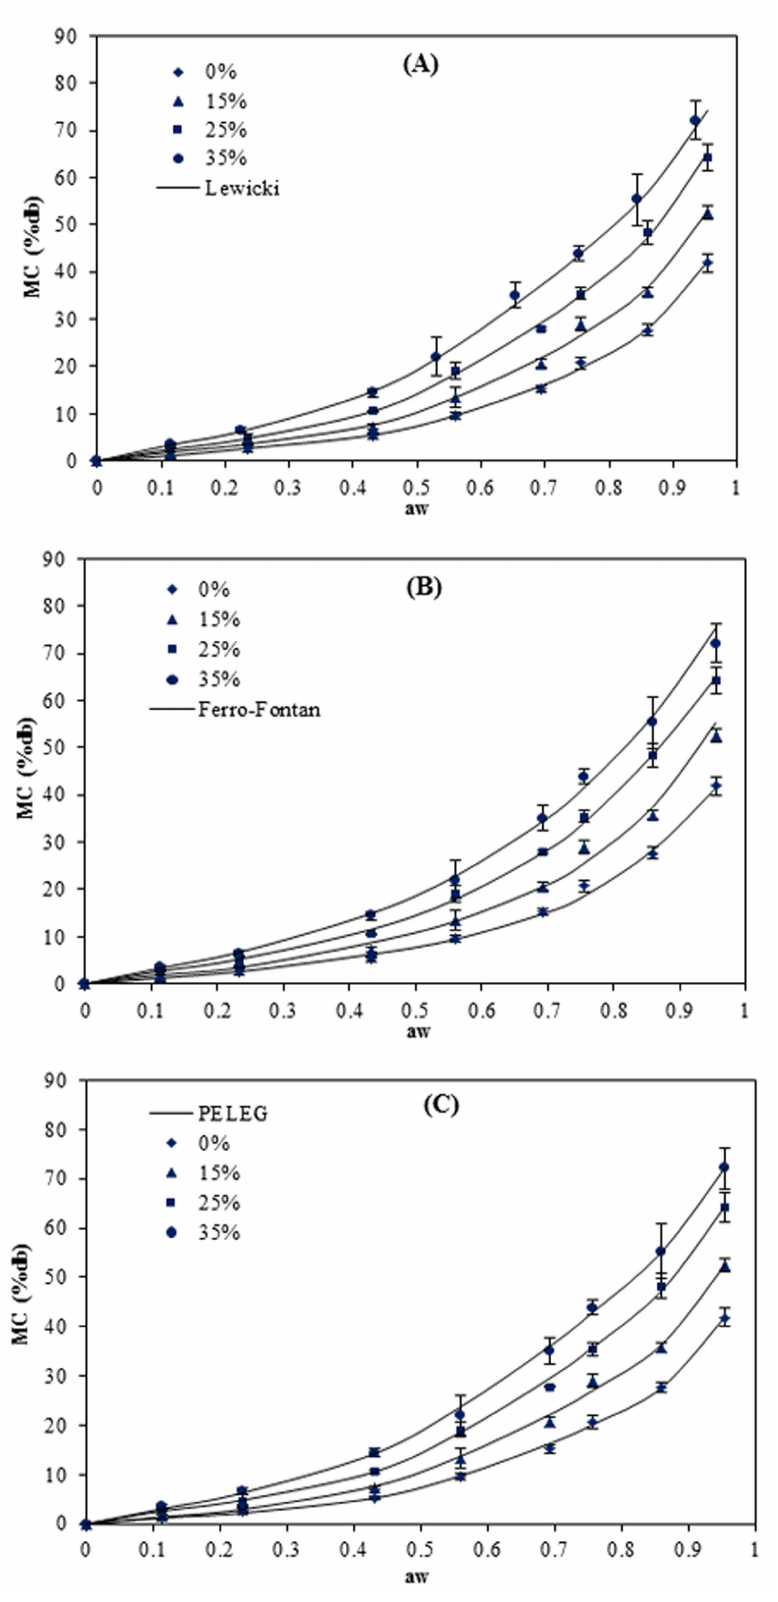
Figure 2. Equilibrium moisture sorption isotherm of pea starch film with different glycerol content ( w / w ) at 15 ˝ C. The symbols are experimental data and the lines are from the equations obtained by fitting the experimental data to Lewicki ( A ), Ferro–Fontan ( B ) and PELEG ( C )